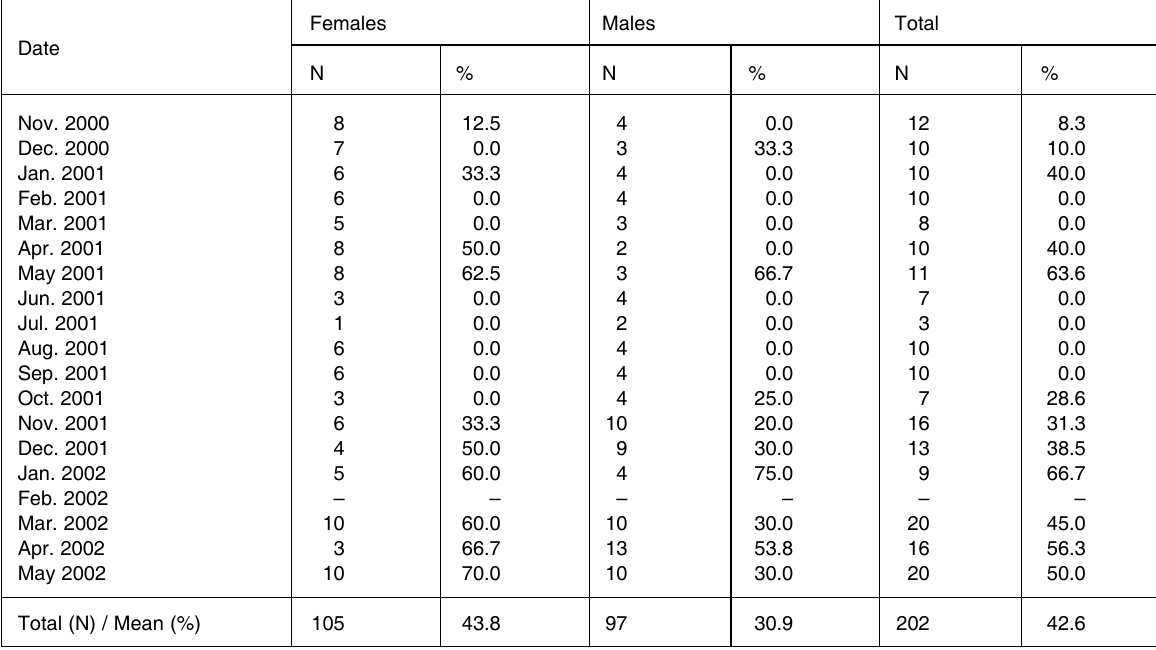
TABLE 1 The prevalence (% infected) of Contracaecum larvae in C. gariepinus from Lake Chivero (November 2000 to May 2002)